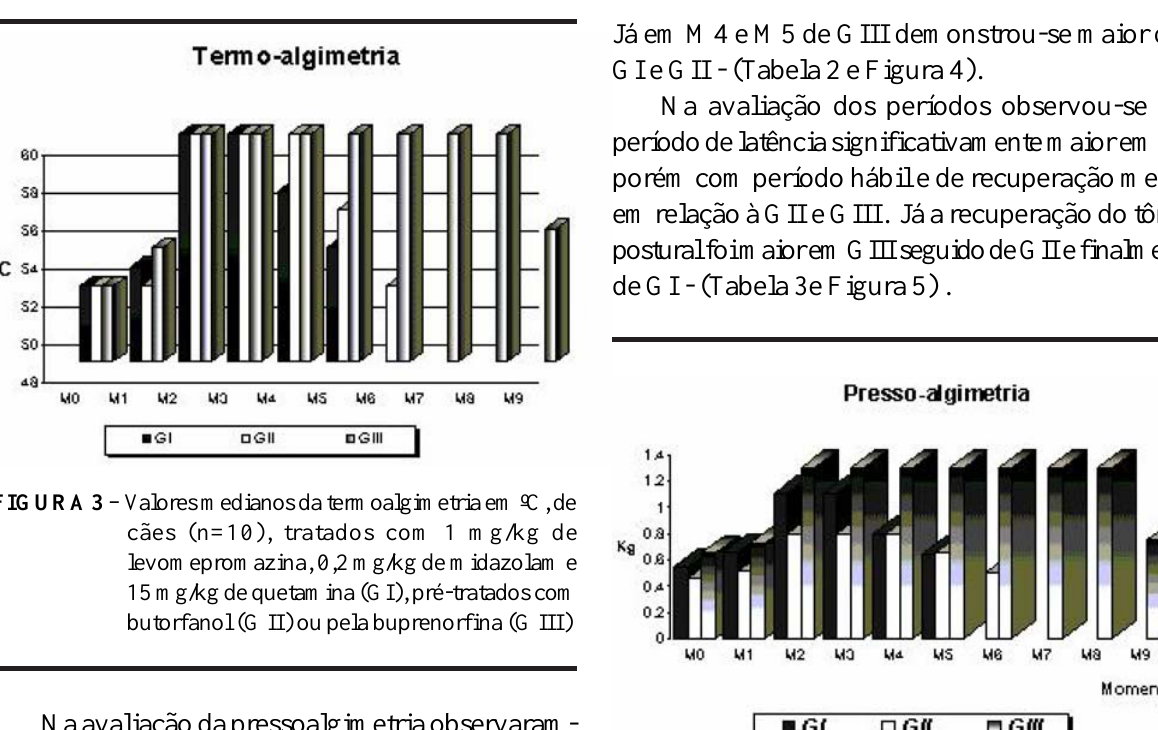
TABELA 2 – Valores medianos, 1 os e 3 os quartis da pressoalgimetria em kg, de cães (n=10), tratados com 1 mg/kg de II) ou pela buprenorfina (G III)